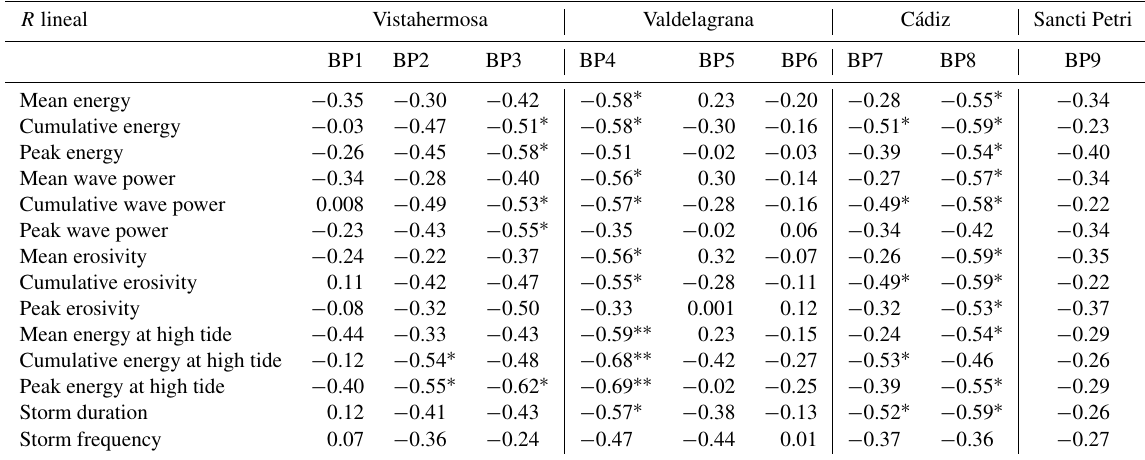
Table 4. Summary statistics of the correlations between shoreline changes and storm parameters ( ∗ significance levels are < 95%; ∗∗ signif- icance levels are <